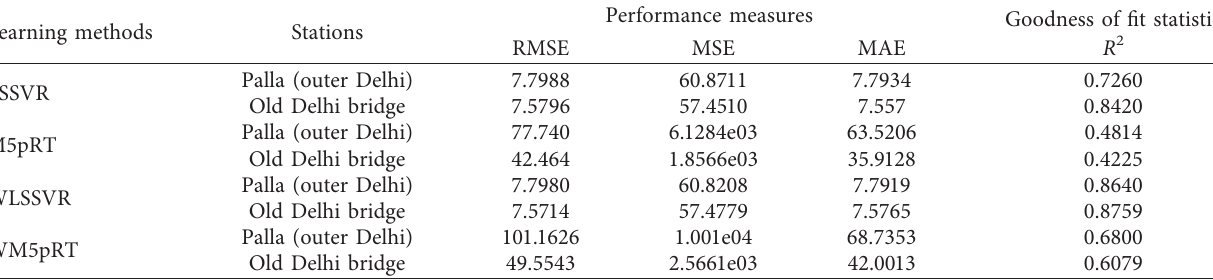
Table 2: Comparison of prediction errors for data recorded two stations.